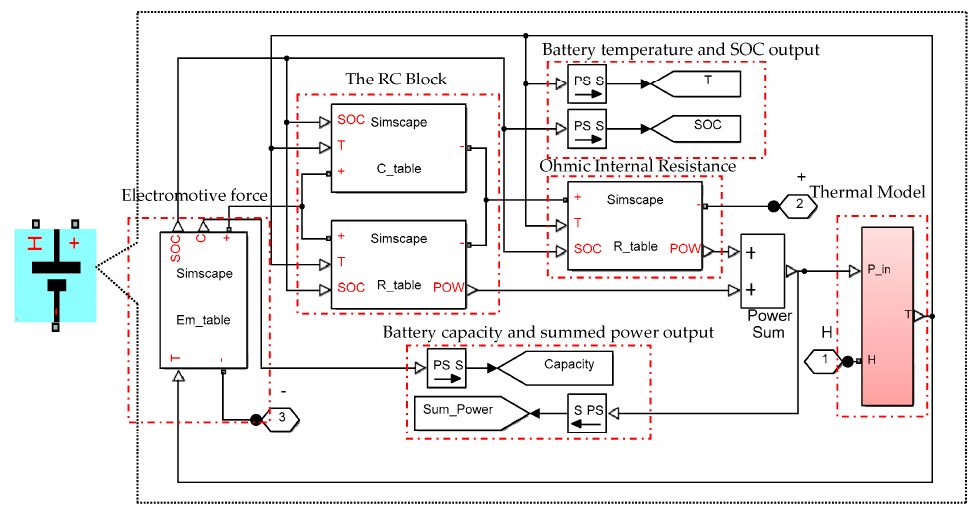
Figure 5. Simscape model of the first-order RC equivalent circuit.